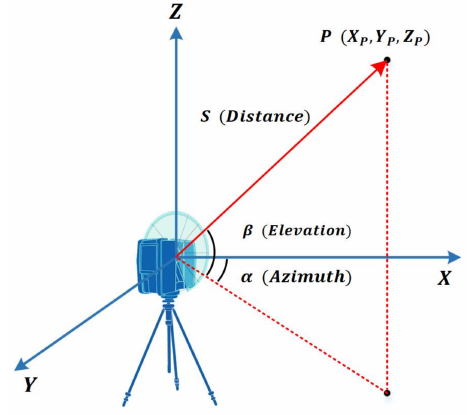
Figure 1. Working principle of a laser scanner.